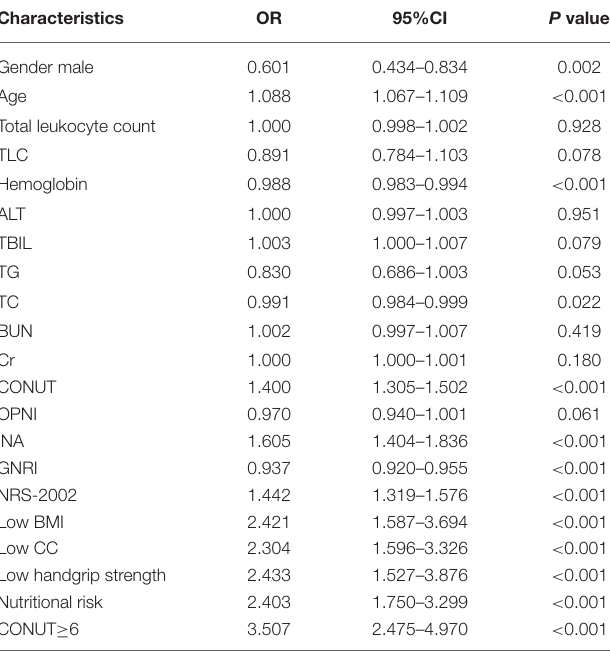
TABLE 3 | Univariate logistic regression analysis of risk factors associated with in-hospital death in older adult patients ( n = 11795).